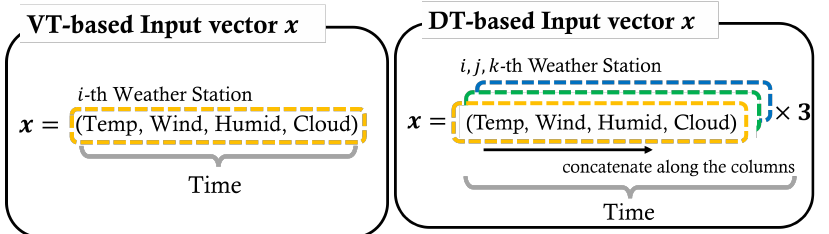
Figure 4. Input vector x for Voronoi Tessellation and Delaunay